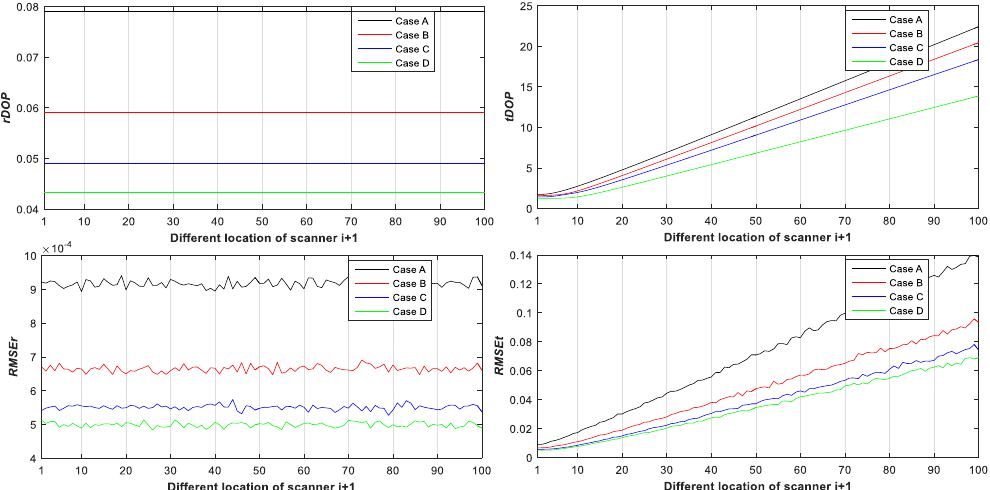
Figure 5. rDOP 3 , tDOP 3 , RMSE r ,3 , and RMSE t ,3 of Case A, B, C, and D with respect to three different targets.